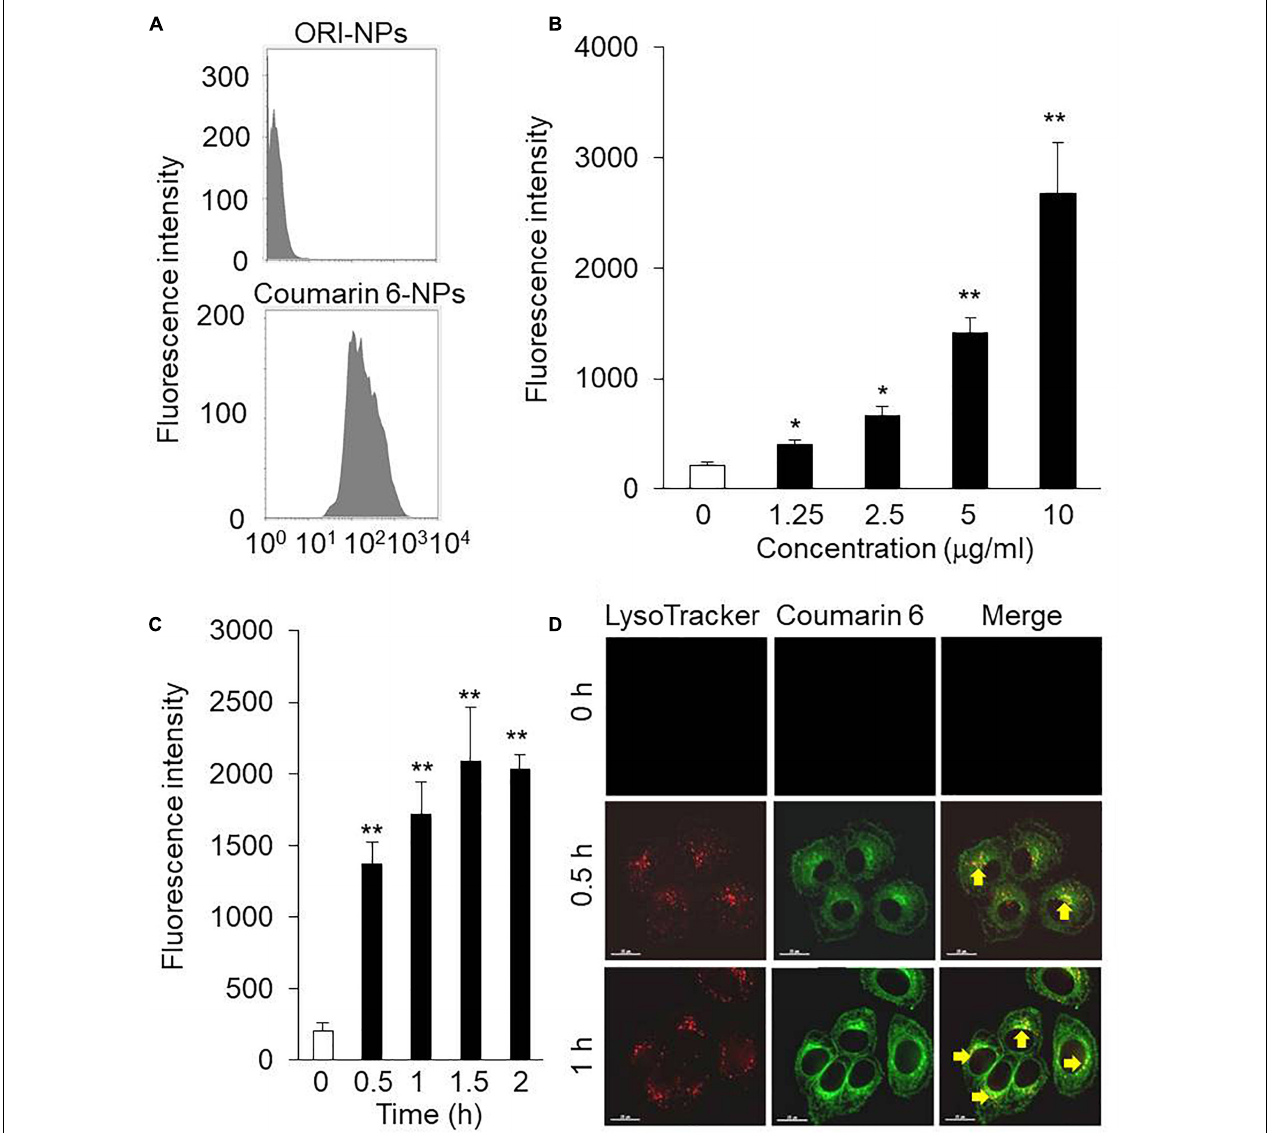
FIGURE 2 | The intracellular uptake of ORI-NPs in MCF-7 cells. (A) Flow cytometry analysis showing fluorescence intensity in MCF-7 cells treated with ORI-NPs and Coumarin 6-loaded NPs. (B) The dose-dependent cellular fluorescence intensity increased in the MCF-7 cells treated with Coumarin 6-loaded NPs for 2 h were assessed by flow cytometry analysis. (C) Time course of cellular fluorescence intensity in the MCF-7 cells treated with 10 µ g/ml Coumarin 6-loaded NPs. (D) Representative images showing the localization of Coumarin 6-loaded NPs in lysosomes after internalized by the MCF-7 cells, lysosome (red color), Coumarin 6 (green color). Scale bar = 15 µ m. (Data were representative three independent experiments. * P < 0.05, ** P < 0.01 versus